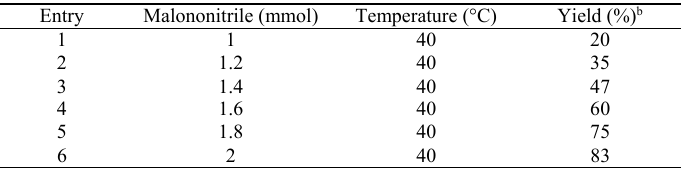
Table 1. Optimization of the amount of malononitrile a .